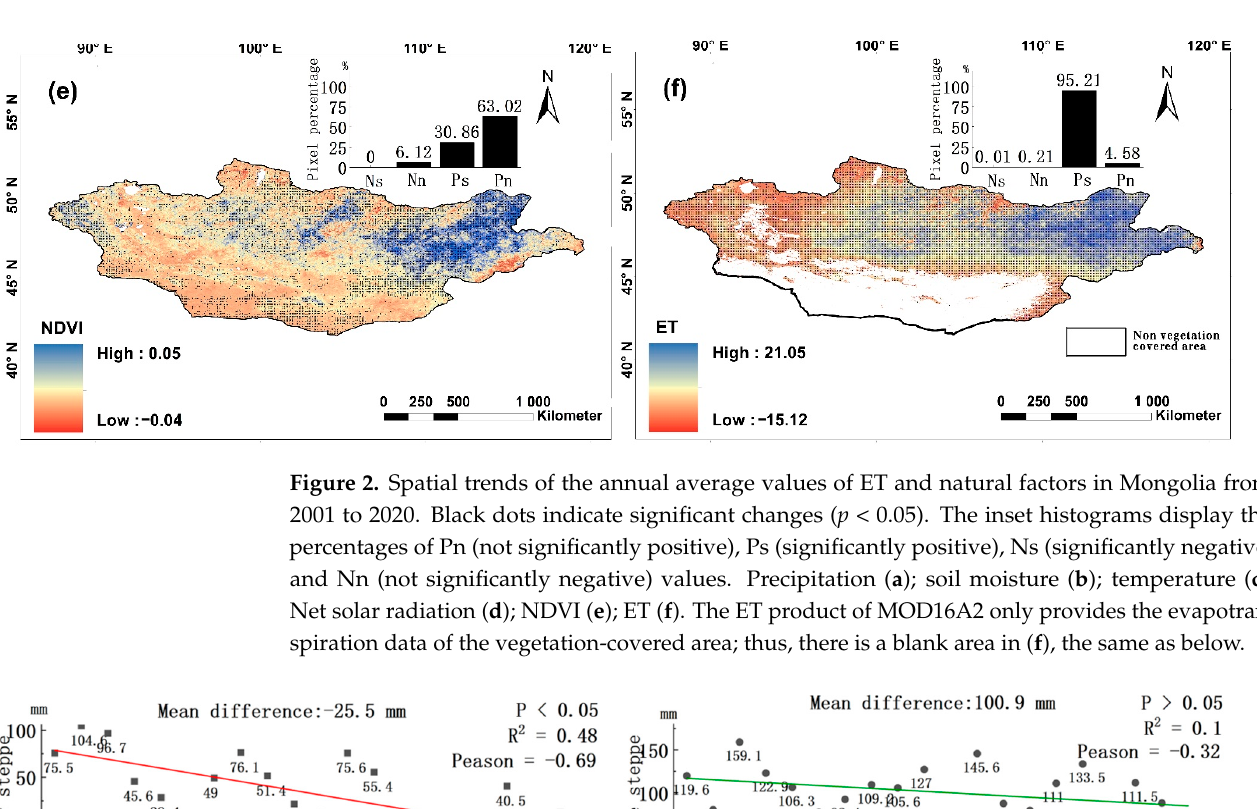
spiration data of the vegetation-covered area; thus, there is a blank area in ( f ), the same as below.